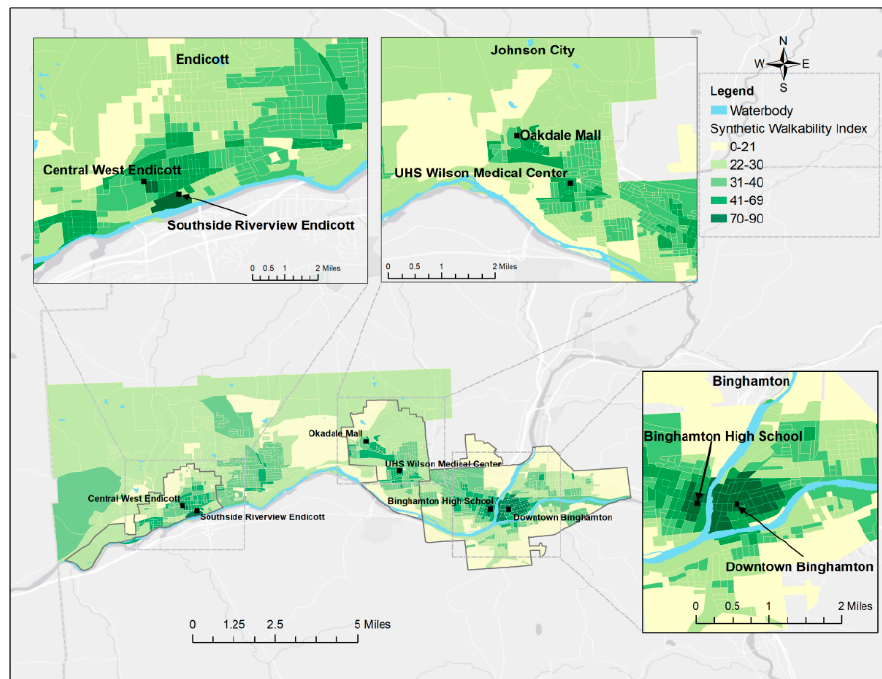
Figure 4. Spatial pattern of synthetic walkability index of the Greater Binghamton Area (showing the mean value at the block level, for illustration purposes